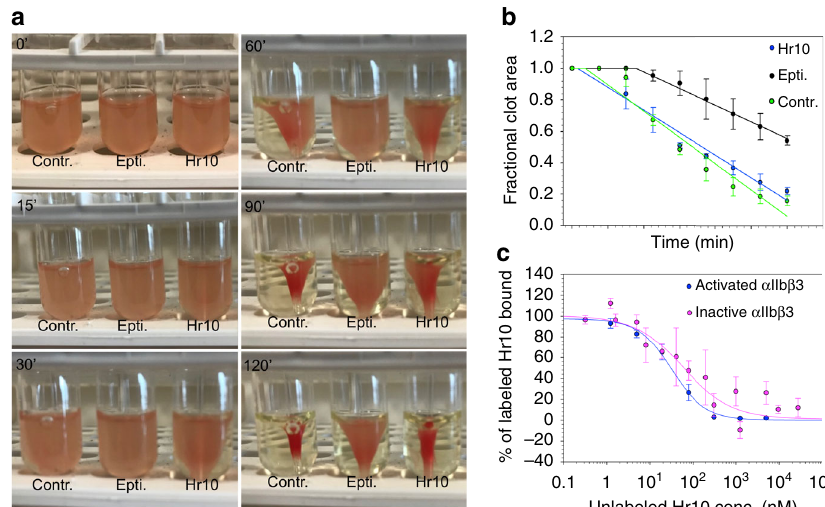
Fig. 5 Clot retraction and integrin binding studies. a Kinetics of clot retraction in the absence (Contr.) and presence of Hr10 or epti fi batide (Epti.) from a representative experiment, one of three conducted. Clot retraction took place around a central glass rod. A total of 5 μ l of red blood cells were added per 1 ml reaction to enhance color contrast for photography. Photographs shown were taken at timed intervals (in minutes) after addition of thrombin. b Time course (mean + / − s.e.) from three clot retraction experiments, including the one shown in Fig. 5a. The plot shows the fractional area occupied by the clot at 15-min intervals with a linear regression through the points. No signi fi cant differences ( p = 0.125, F -test, two-tailed) were found in kinetics of clot retraction in buffer vs. Hr10. A lag period is noted with epti fi batide and clot retraction was signi fi cantly reduced vs. buffer ( p = 4.5 × 10 − 15 , F -test, two- tailed). c Dose – response curves comparing displacement of Alexa488-labeled Hr10 binding to PT-25-activated α IIb β 3 on K562 cells by increasing concentrations of unlabeled Hr10 with that to the inactive receptor (Fig. 2a). Cell binding was analyzed by FACS. The mean fl uorescence intensity (MFI) values of binding to active α IIb β 3 (mean + / − s.e. of three independent experiments) were initially fi t with a binding curve to determine minimum and maximum MFI values to use in scaling the data. The points and error bars indicate the mean and standard error for the scaled data. The red and black lines are a least-squares fi t to the averages. No signi fi cant differences were found ( p = 0.54, F -test, two-tailed).